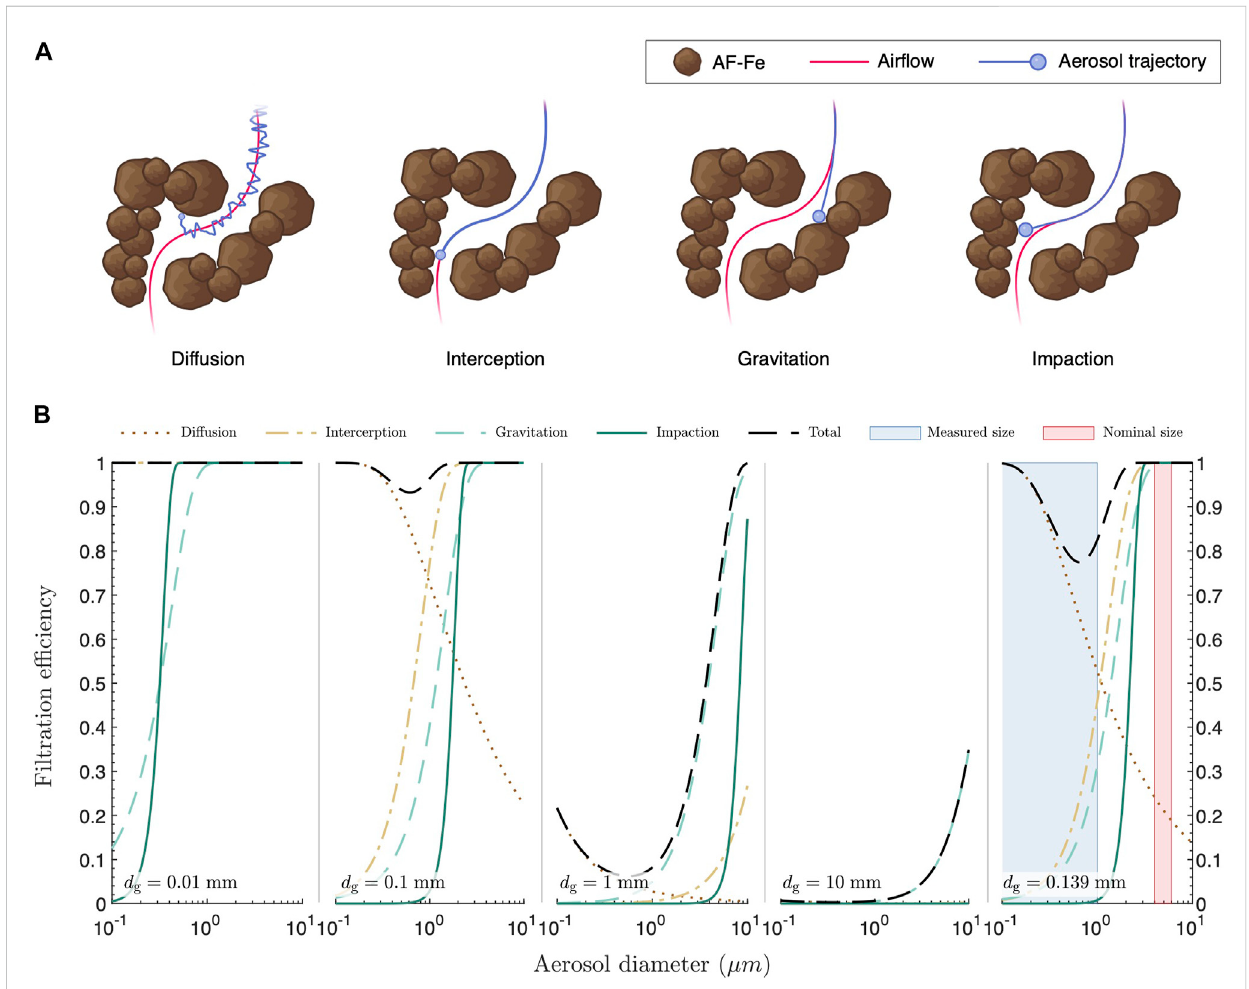
Mechanisms of aerosol entrapment. (A) Schematics depicting different processes involved in aerosol entrapment. (B) Filtration ef fi ciencies due to diffusion, interception, gravitational settling, and impaction through grain bed fi lters with monodispersed grain size, d g , which was varied systematically between 0.01 and 10 mm. d g (cid:2) 0 . 139mm was calculated using Ergun ’ s equation based on the measured pressure drop across the AF-Fe fi lter. In (B) , the nominal size indicates the diameter range of freshly nebulized droplets according to the manufacturer, while the measured size indicates the range of aerosol diameters at a relative humidity (RH) of 80% – 85% (Supplementary Figure